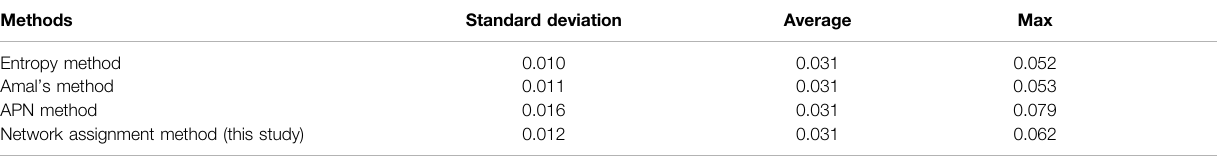
TABLE 4 | Statistical characteristics of weight results by different methods.